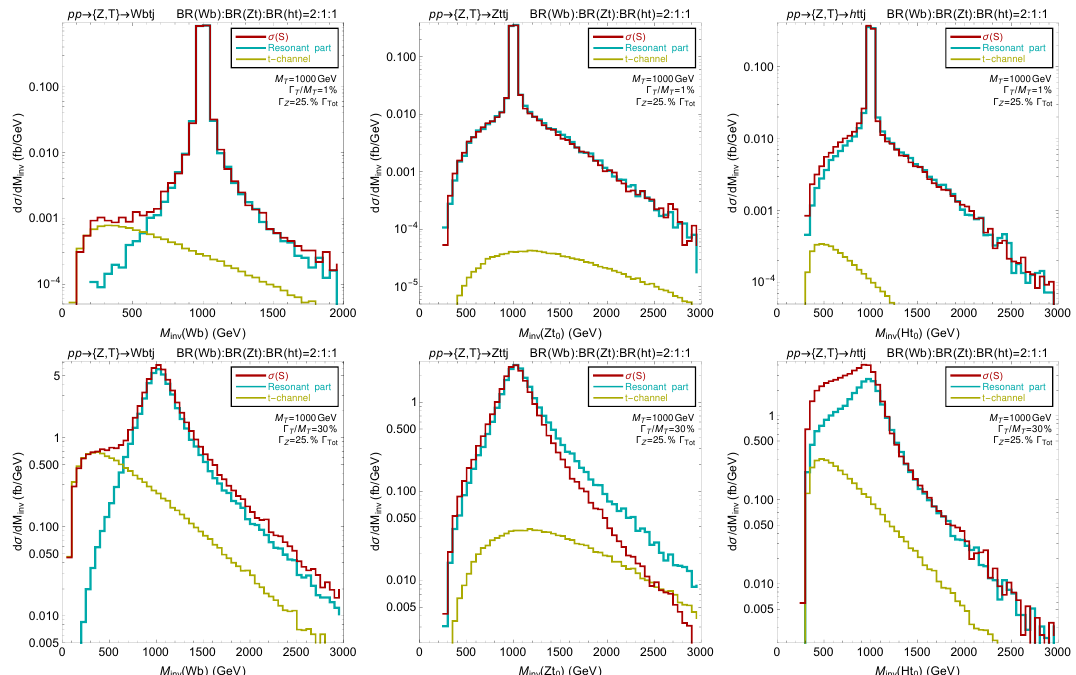
Figure 20 . Same as figure 3 for the processes pp → Wbtj (left), pp → Zttj (centre) and pp → httj (right), with m = 1 TeV. T